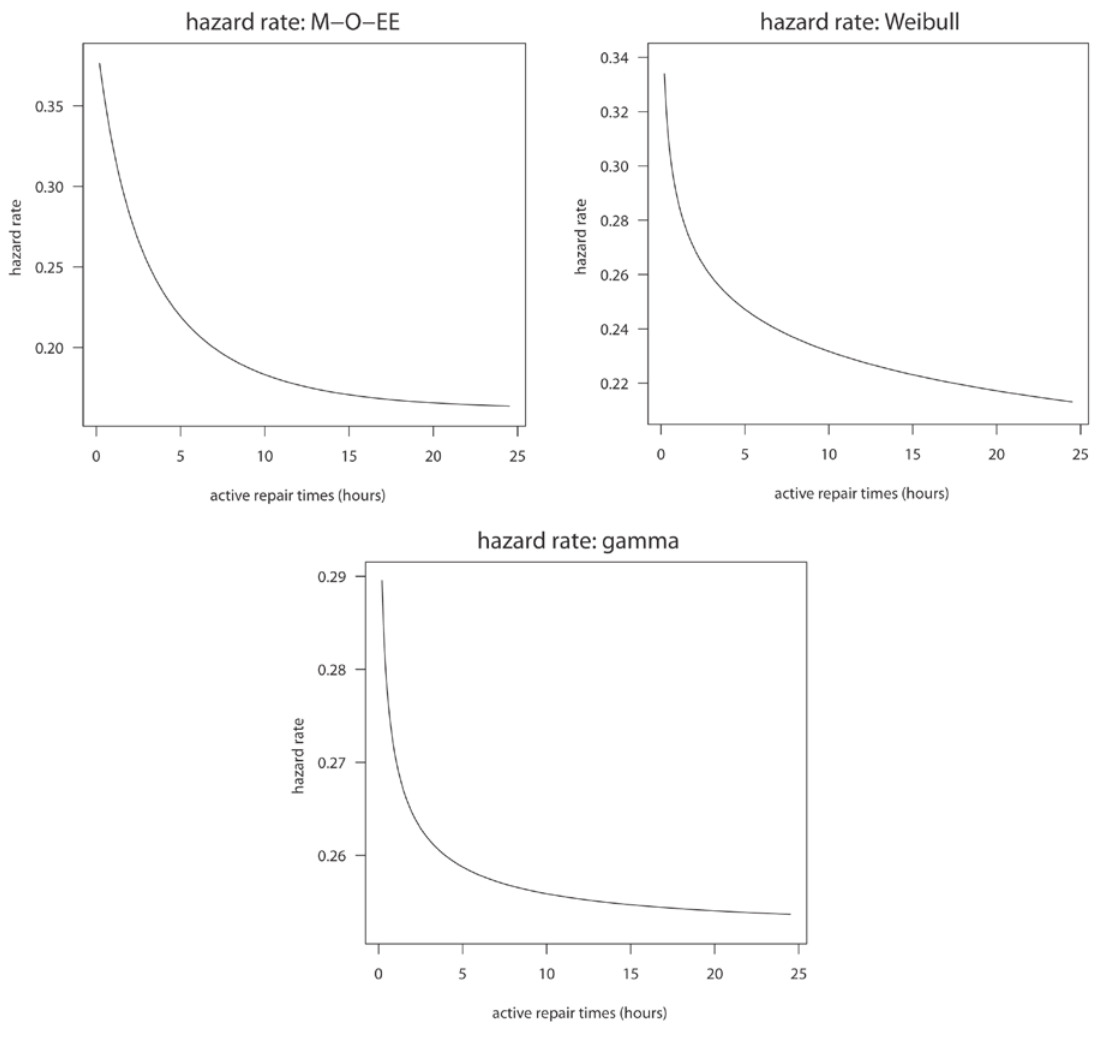
Figure 2 - Estimated hazard rate of the Marshall-Olkin extended exponential (M-O-EE), Weibull and gamma models for a real data